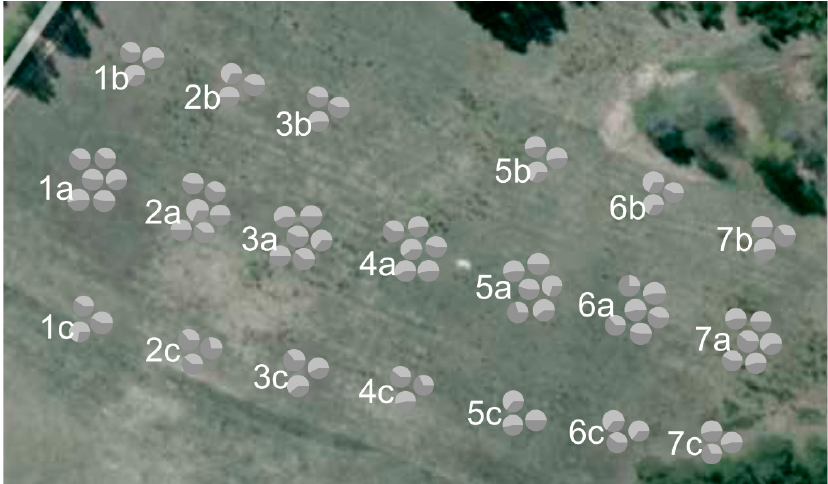
Figure 5. Spatial distribution map of sampled silver birch ( Betula pendula Roth.) juveniles regenerating on abandoned agricultural land (see Figure 1 for the principal sampling scheme). Pie charts show the assignment of individual juvenile MLGs to the two most likely genetic clusters, as revealed by STRUCTURE (indicated in different shades of grey).